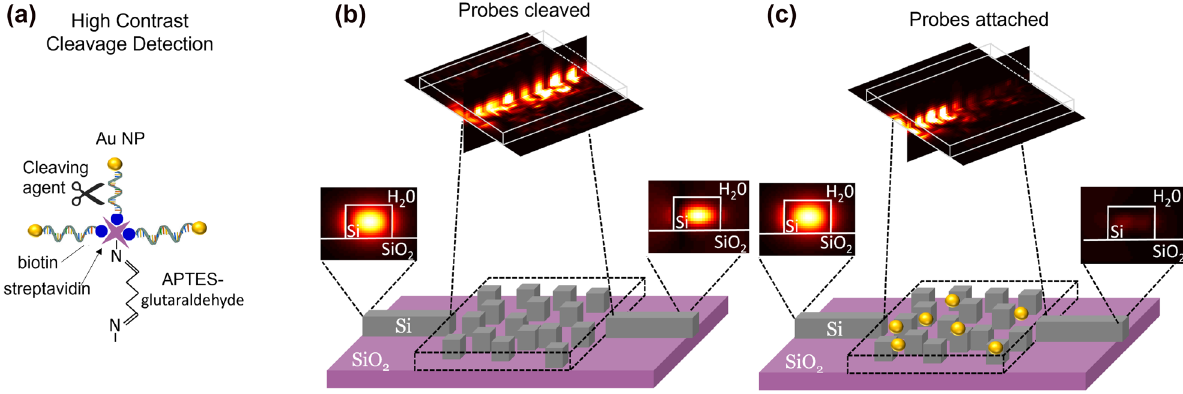
Figure 2: Construction and operation of the integrated inverse-designed waveguide-based biosensor. (a) A schematic of the high contrast cleavage detection (HCCD) mechanism. (b) The inverse-designed biosensor consists of SiO and Si-cubic structure which has a minimum feature size of 50 × 50 × 220nm. The device is inverse-designed to be nearly fully-transparent for the 1550 nm wavelength light propagating along the bus waveguide. (c) The sensor surface is initially functionalized with high-contrast probes (gold nanoparticles), which almost completely block light propagation through the sensing area. After the probes are cleaved by the target-activated CRISPR complex, the device transparency is restored, with the light intensity in the through channel serving as the sensor optical readout signal.